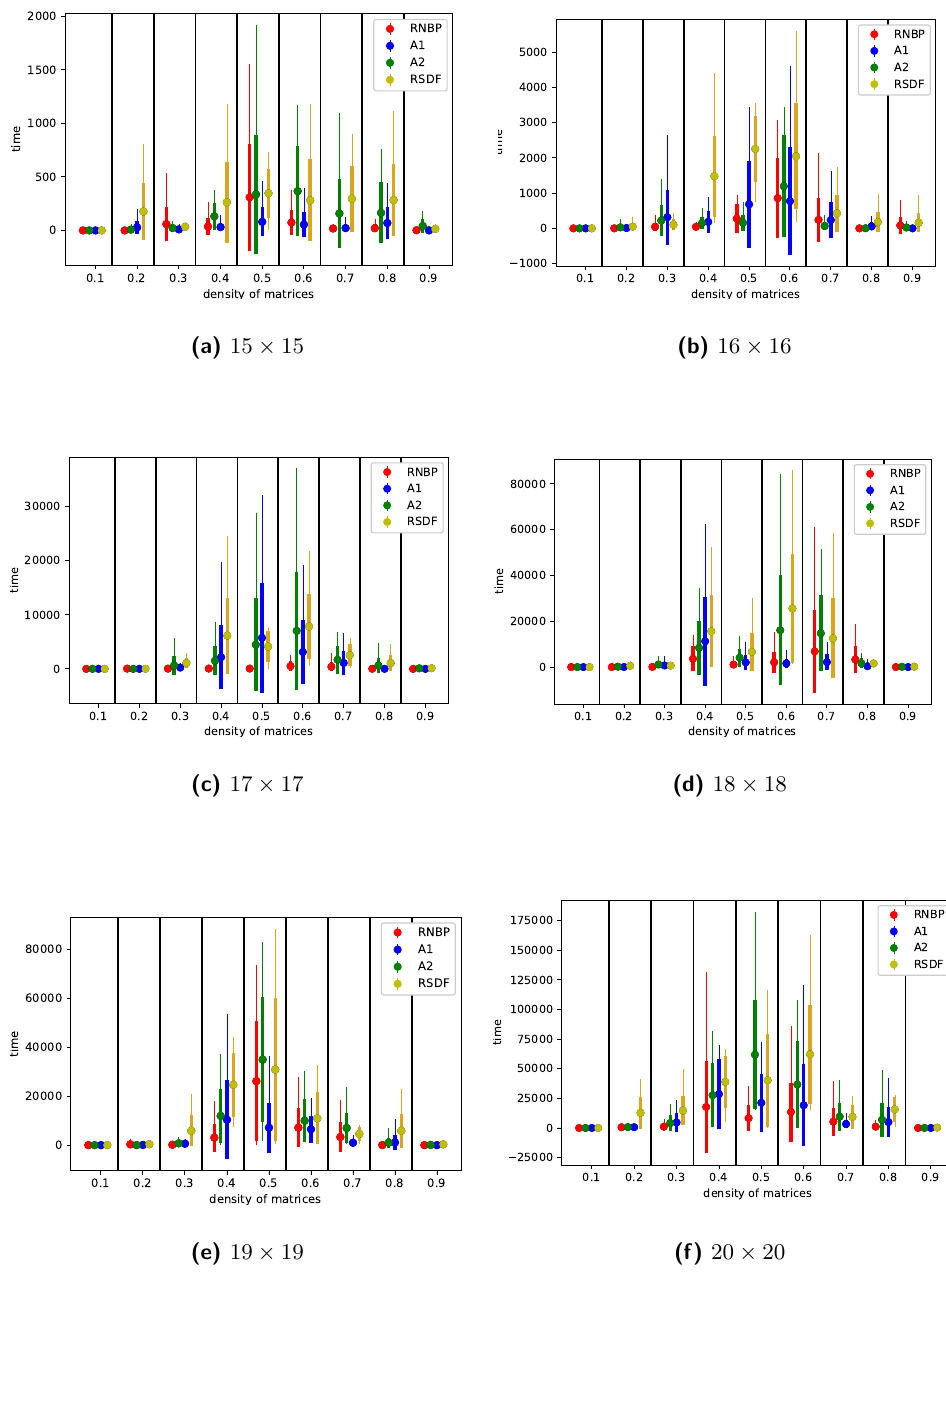
Figure 7: Average time taken to stability of 15 × 15 to 20 × 20 matrices. For every matrix, the time taken until the best circuit is formed is recorded. The average, standard deviation, minimum and maximum time (of ten matrices in each category) are shown below